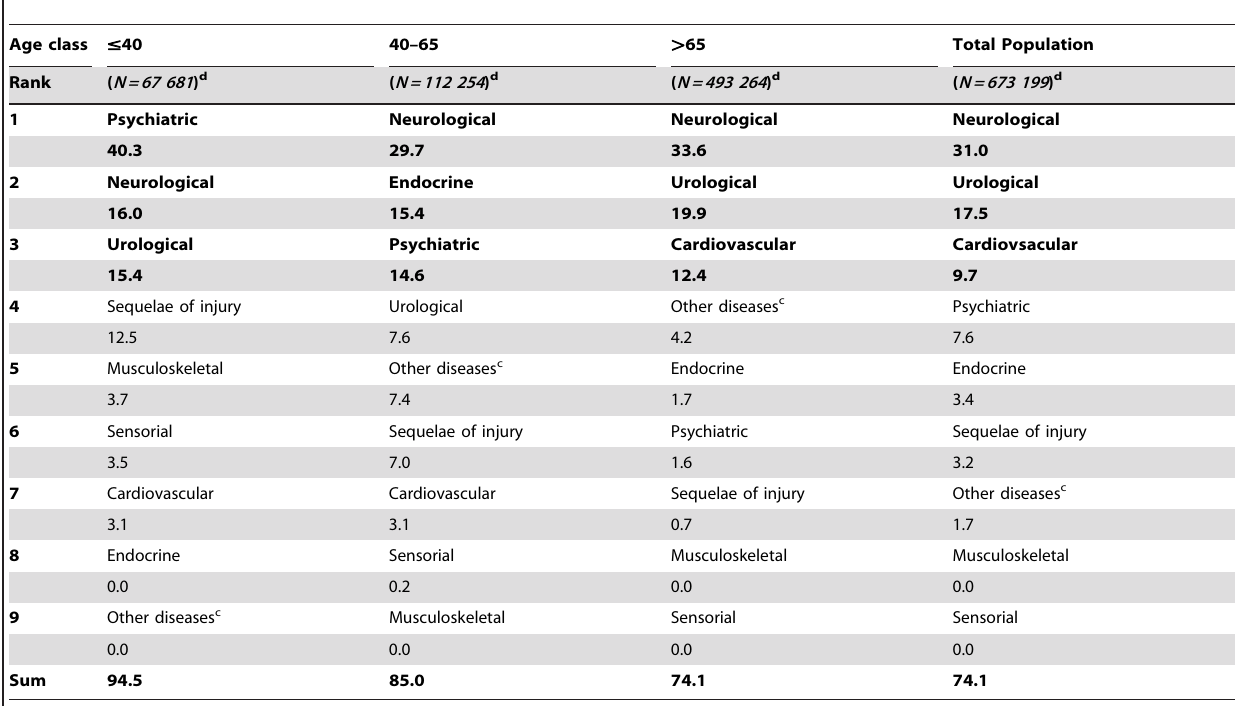
Table 5. Average attributable fraction a (AAF) estimates (%) for each chronic disorder for severe disability b in